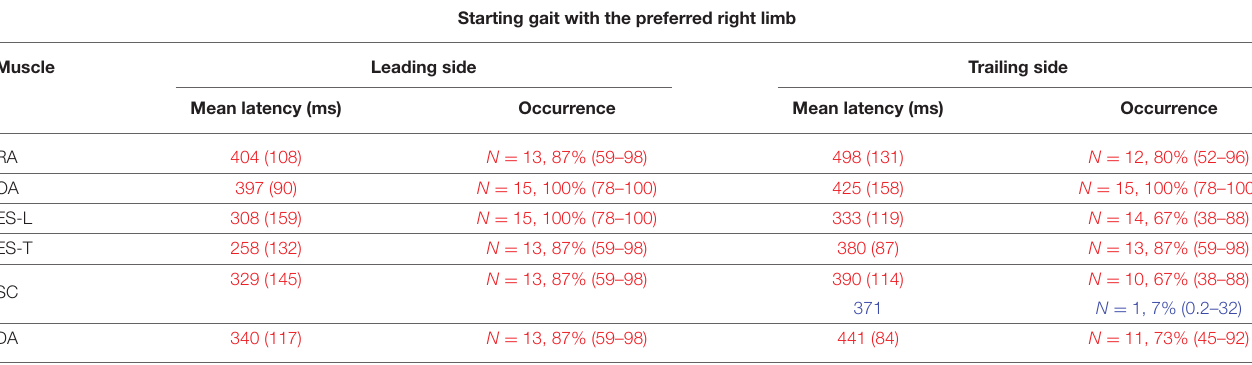
TABLE 3 | Mean latency of the change in electromyographic (EMG) activity occurring between CoP onset and heel-off, with SD (in parentheses), when starting gait with the preferred